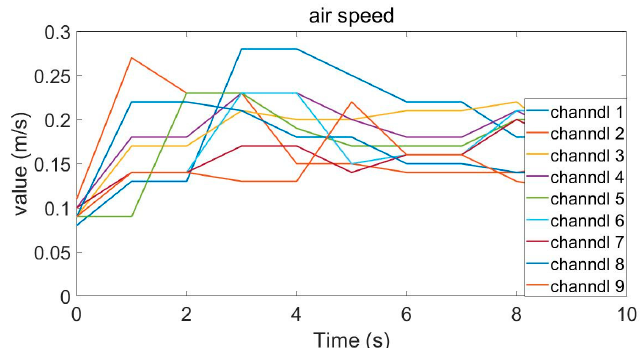
Figure 12. Wind speed profiles of experiment.